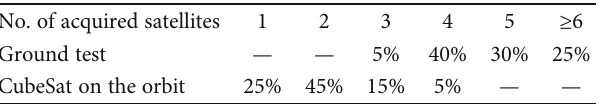
Figure 16: Normalized histogram of the PDOP. The lower the value, the better. Table 5: Relative frequency of the acquisition of the given number of the satellites by an acquisition